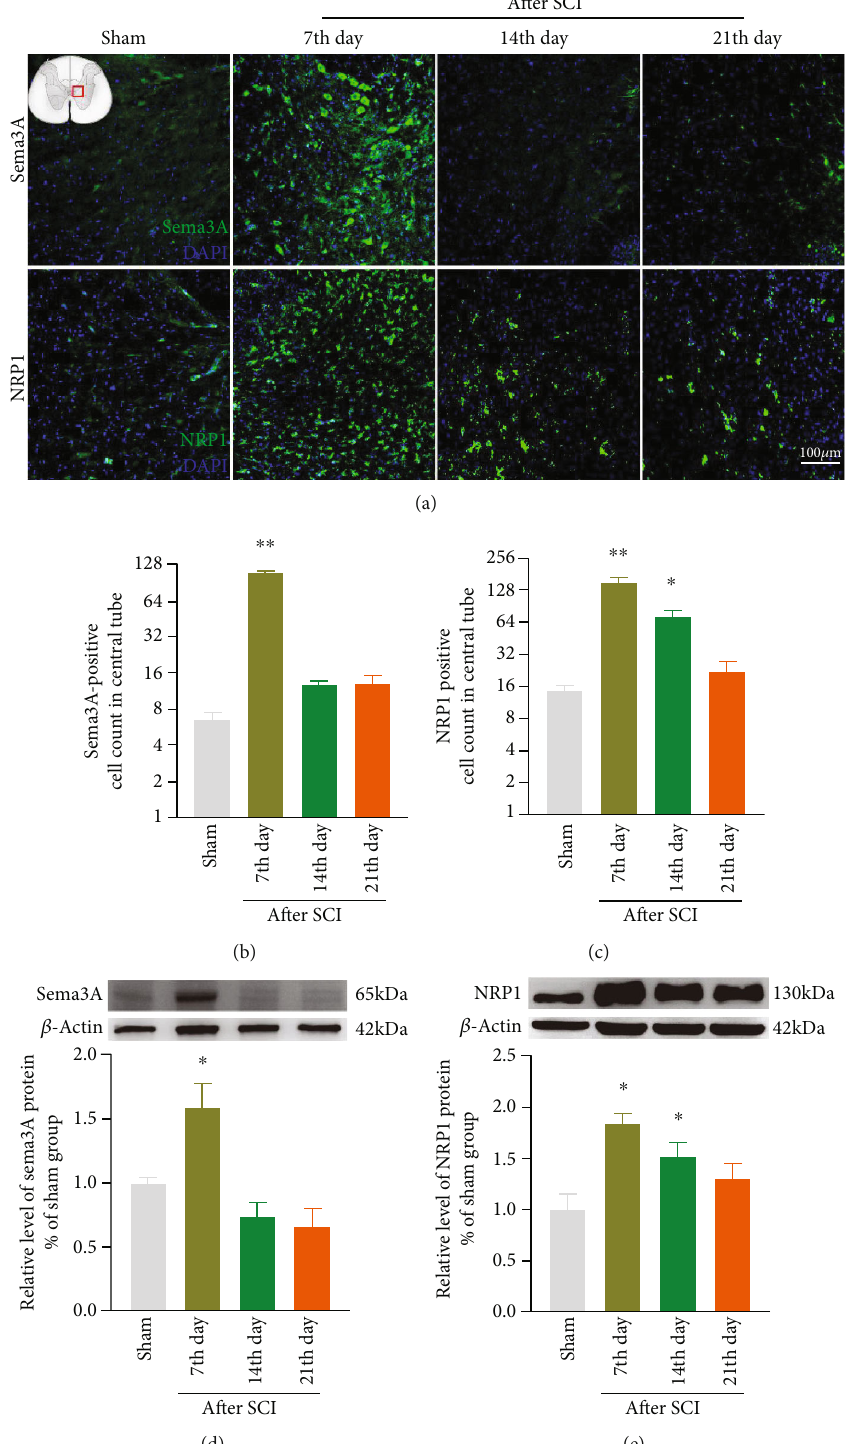
Figure 3: The expression of Sema3A and its receptor NRP1 were upregulated around the central gray matter of the spinal cord after SCI. (a) The results of immuno fl uorescence showed the expression of Sema3A and its receptor NRP1 around the central canal of the spinal cord gray matter in the sham group and the SCI group. (b, c) Quanti fi cation of immuno fl uorescence data in panel (a), n = 3 . (d, e) Representative bands and statistics of Sema3A and NRP1 in the spinal cord by Western blotting, n = 5 , compared with the sham group, ∗ P < 0 : 05 , ∗∗ P < 0 : 01 . All data are presented as the mean ± SEM